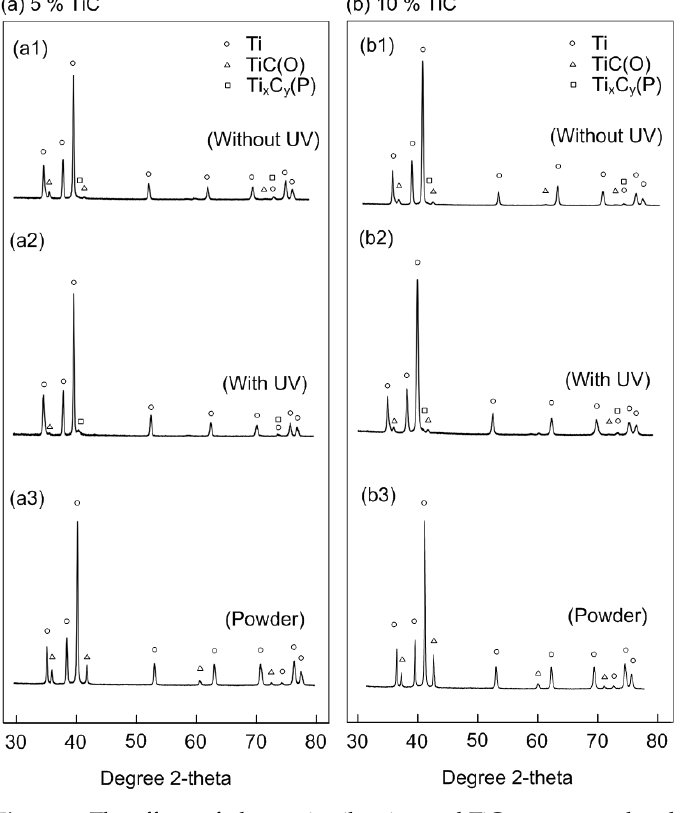
balance Table 3. Phase compositions of the feedstock powder and the TiC-TMC coatings with 10% TiC. Conditions